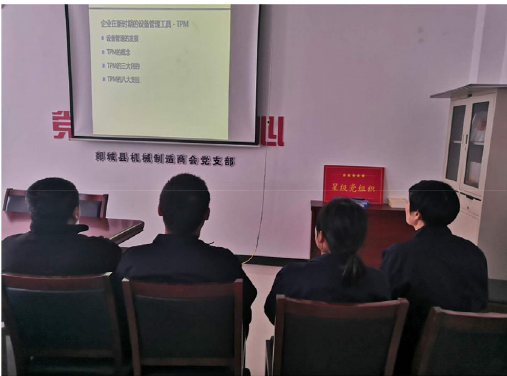
Figure 6. TPM Training was carried out to the first batch of